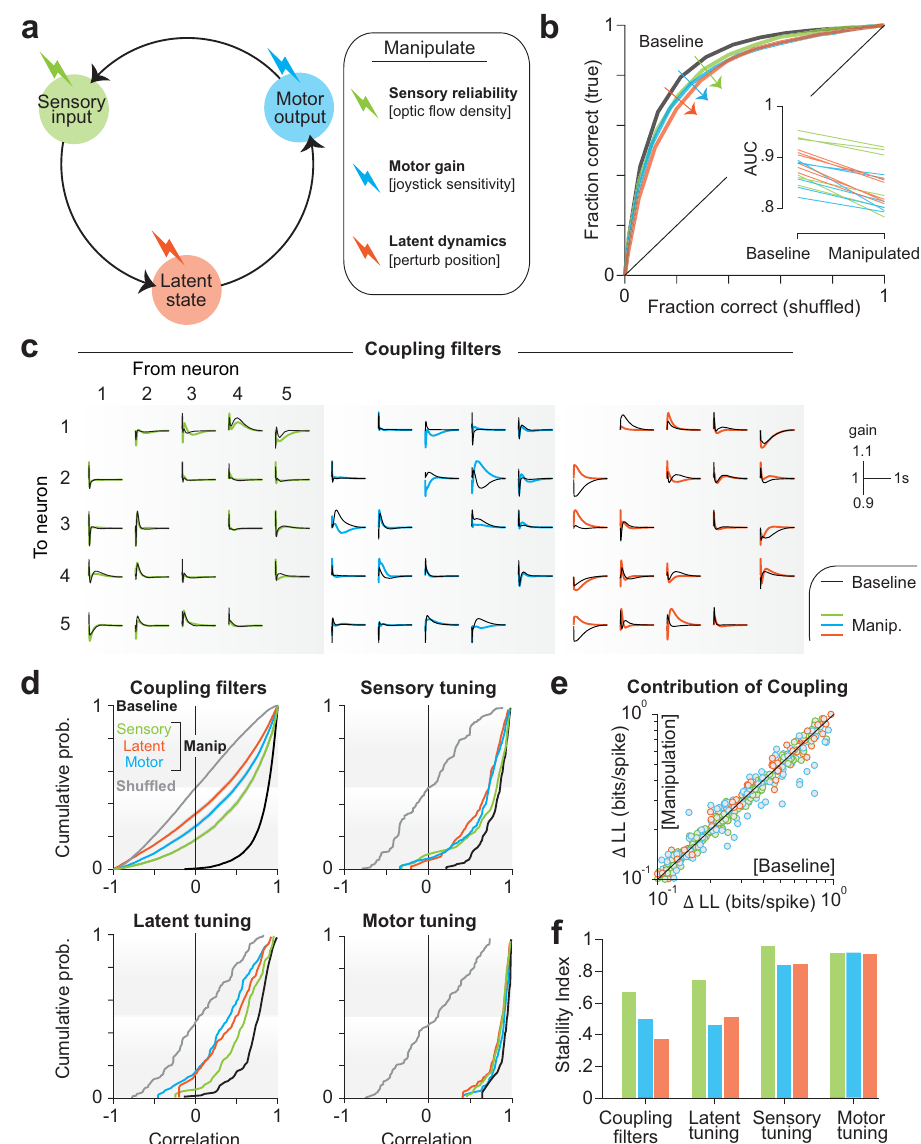
Fig. 6 | Behavioral manipulations trigger changes in coupling and latent representation. a In separate experimental sessions, we manipulated sensory input (by altering the density of optic fl ow), motor output (by altering the sensi- tivity of the joystick), or latent state (by perturbing the monkey off his intended trajectory while traveling) ( “ Methods ” ). b These manipulations produced modest behavioral effects as shown by the ROC curves for a subset of experimental ses- sions,quanti fi edasareaunderthecurve(AUC,inset). c Coupling fi lters(shownfora representative subset of all directed pairsof fi ve neurons) fi t to datafrom baseline trials (gray) and manipulation trials (colored). d Top left: Cumulative distribution acrossallpairsof neuronsof the correlationcoef fi cientbetweencoupling fi lters fi t tobaselinetrialsandmanipulatedtrials.Blackcurveshowsthebaselinedistribution computed using odd and even baseline trials. Gray curves show the null distribu- tion constructed by shuf fl ing the neuronal pairs. Shaded regions denote ±1 SEM estimated by bootstrapping ( n =25,805/20,798/22,506 neuron pairs for sensory/ task manipulations. We observed that all three manipulations altered coupling, albeit to varying degrees (Figs. 6c and S6b). For each pair of neurons, we quanti fi ed the degree to which coupling was altered by computingthecorrelationbetween fi lters fi ttodatarecordedwithand without task manipulation (Fig. 6d — top left in color). Under all manipulations,themediancorrelationdroppedsigni fi cantlybelowthe noise ceiling de fi ned as the correlation between couplings fi t to odd/